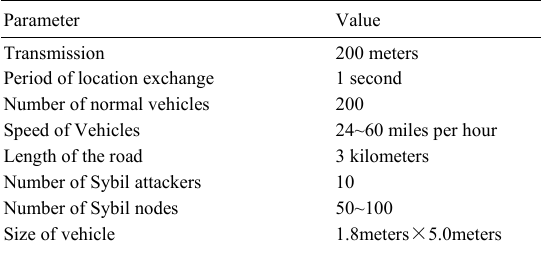
Table 1. Simulation Parameters.